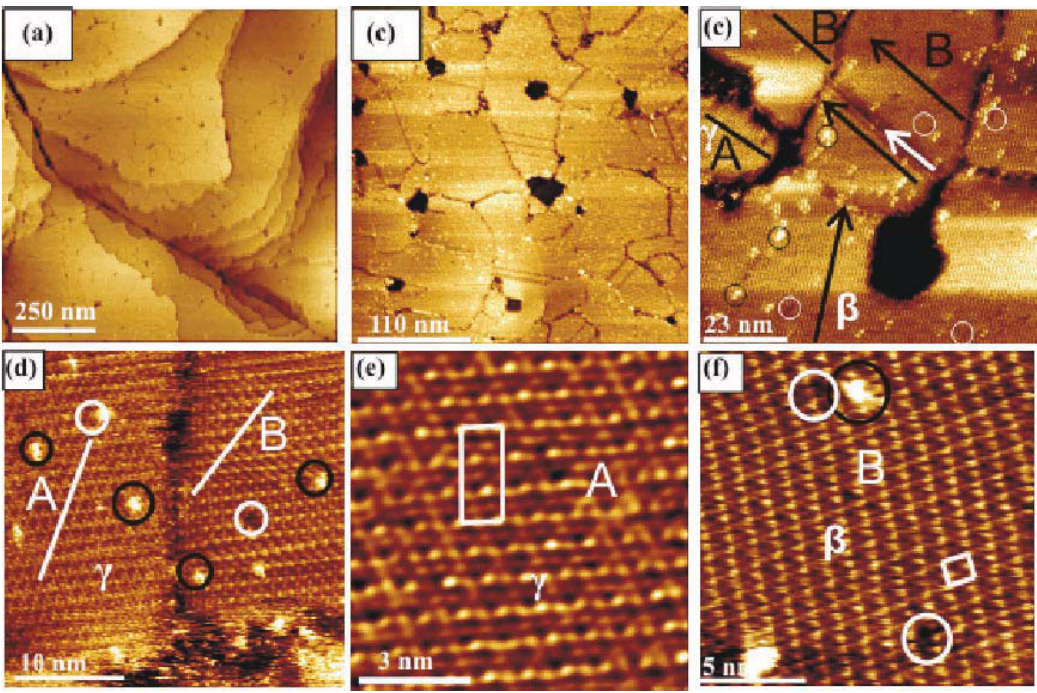
Figure 3. Constant-current images for a Au(111)-substrate, which has been immersed for 2 h into 100 μM solution of BP2 in ethanol 343 K. The arrows in (c) show the direction of the ordered domains. The regions surrounded by the black and white circles show the small-elevated islands and the nearby vacancy islands, respectively. The unit cell of the rectangular (5 √ 3×4) and (2 √ 3×3) structures are marked in (e) and (f), respectively. Tunneling parameters: (a) U= 1000 mV; I= 150 pA, (b) U= 1000 mV; I= 150 pA, (c) U= 530 mV; I= 150 pA, (d) U= 530 mV; I= 150 pA, (e) U= 530 mV; I= 148 pA, and (f) U= 530 mV; I= 148